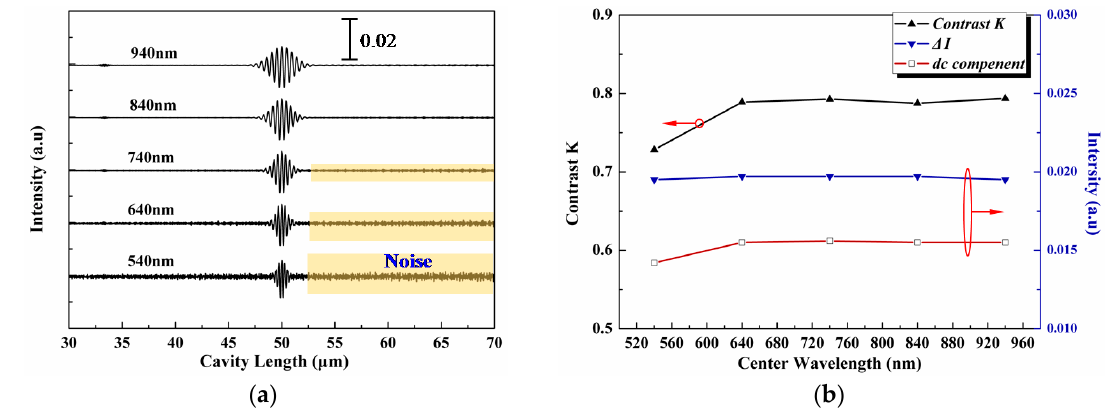
Figure 6. The simulation result of different central wavelength at the same bandwidth 200 nm, ( a ) the demodulation intensity, ( b ) the corresponding contrast K , intensity dc , and Δ I .